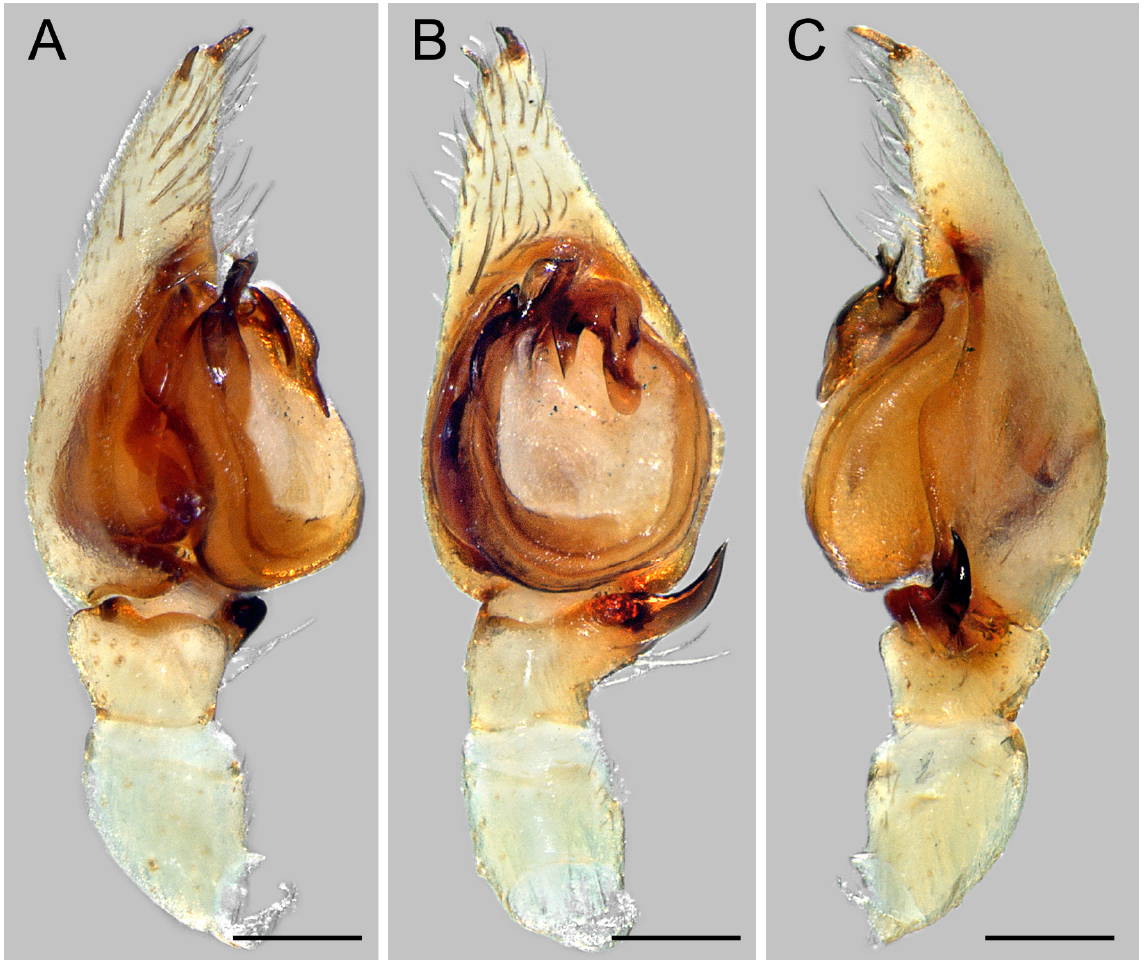
Fig. 7. Acanthinozodium sahelense sp. nov., holotype ♂, palp. A . Prolateral view. B . Ventral view. C . Retrolateral view. Scale bars = 0.2